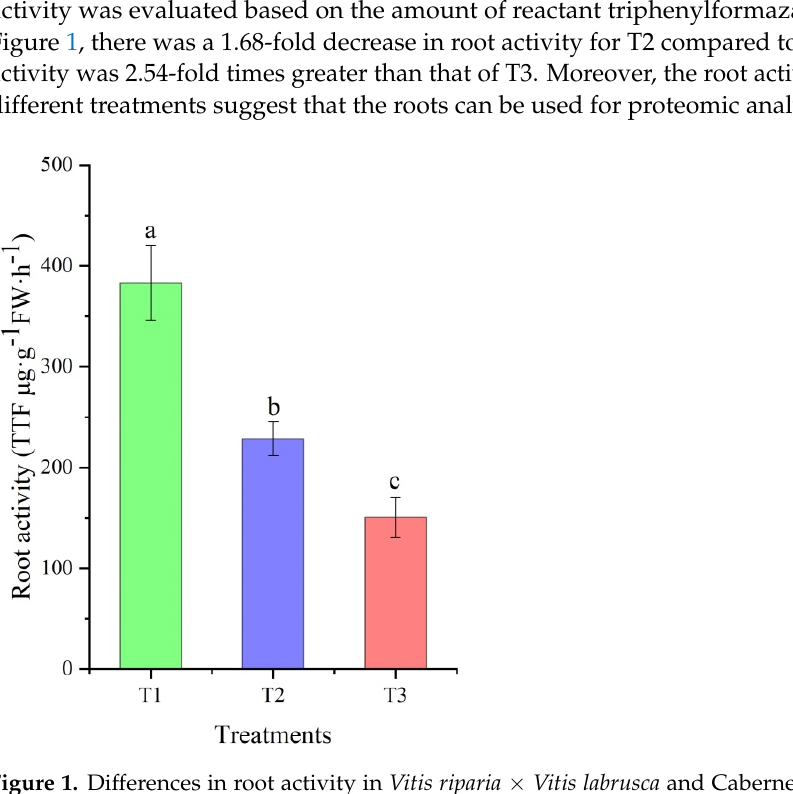
Figure 1. Differences in root activity in Vitis riparia × Vitis labrusca and Cabernet Sauvignon with different treatments. T1: V. riparia × V. labrusca at − 4 °C ; T2: V. riparia × V. labrusca at − 15 °C; T3: different treatments. T1: V. riparia × V. labrusca at − 4 ◦ C; T2: V. riparia × V. labrusca at − 15 ◦ C; Cabernet Sauvignon at − 4 °C. Different lowercase letters represent a significant difference ( p < 0.05) T3: Cabernet Sauvignon at − 4 ◦ C. Different lowercase letters represent a significant difference for the different treatments. ( p < 0.05) for the different